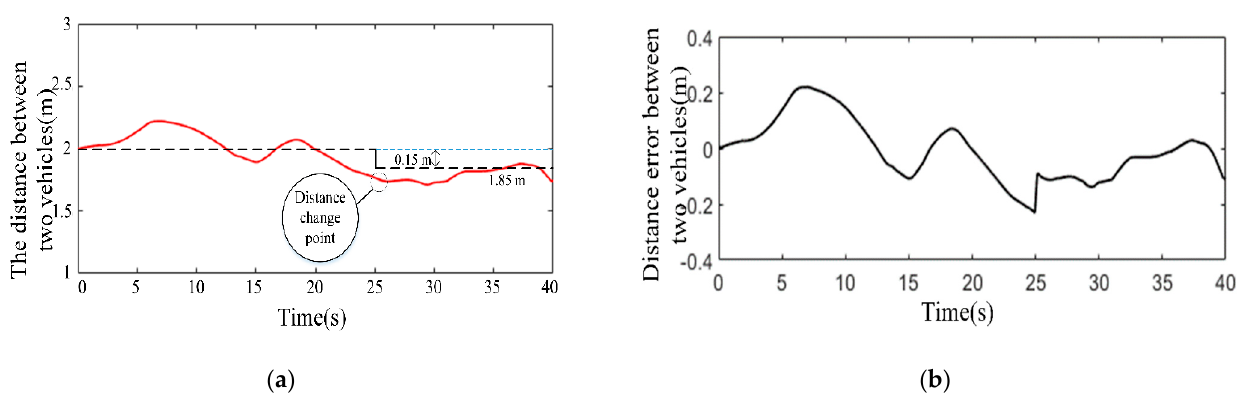
Figure 11. Follow distance diagram and distance error diagram. ( a ) diagram of the distance between two vehicles; ( b ) Error diagram of distance between two vehicles.